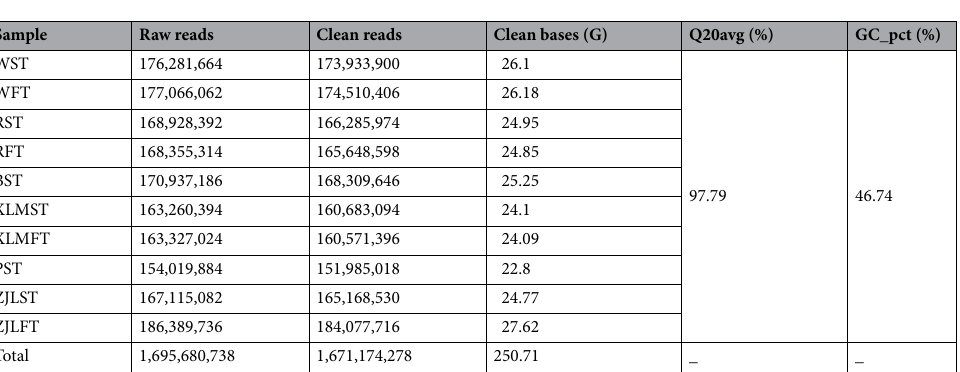
Figure 2. Pigment contents in the skin and flesh of radish taproots. ( A ) The color of the supernatant of the sample extracts. ( B ) Total anthocyanin content of the skin and flesh of radish taproots.